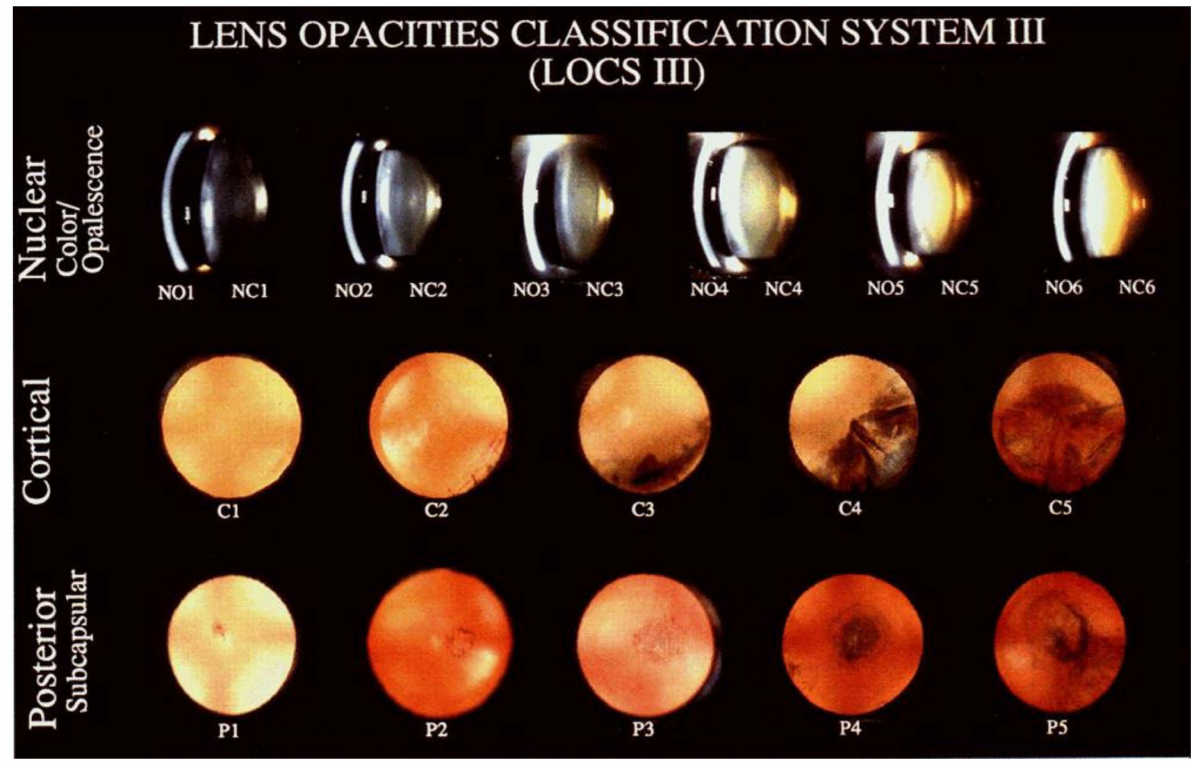
Figure 2. LOCS III Grading Standard